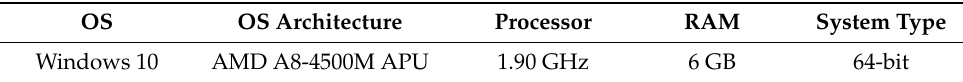
Table 12. software and hardware